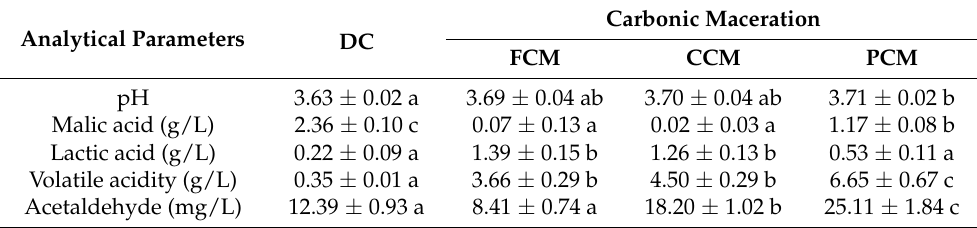
Table 2. Chemical composition of the wines vinified by destemming and crushing or by carbonic maceration at the end of alcoholic fermentation. FCM: free carbonic maceration wine, CCM: crushed carbonic maceration wine, PCM: press carbonic maceration wine. Different letters in the same line mean significant differences between samples ( p <